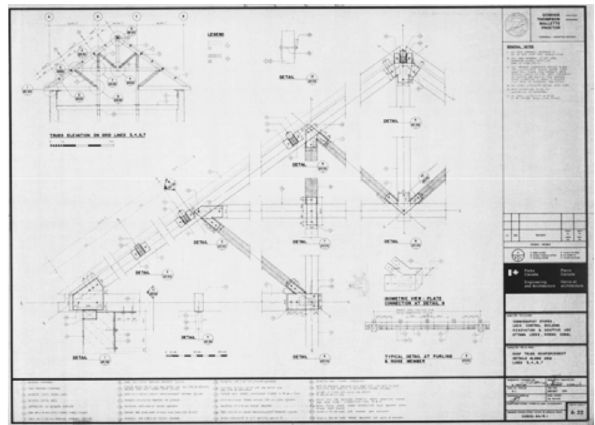
Figure 3. Sheet 22 “Roof Truss Reinforcement,